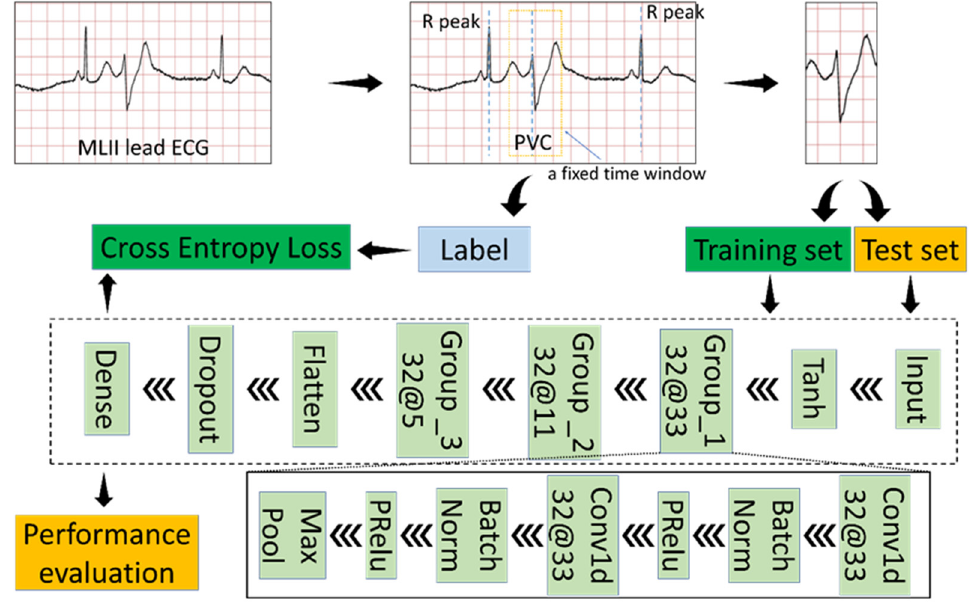
Figure 4. Block diagram of the proposed study.